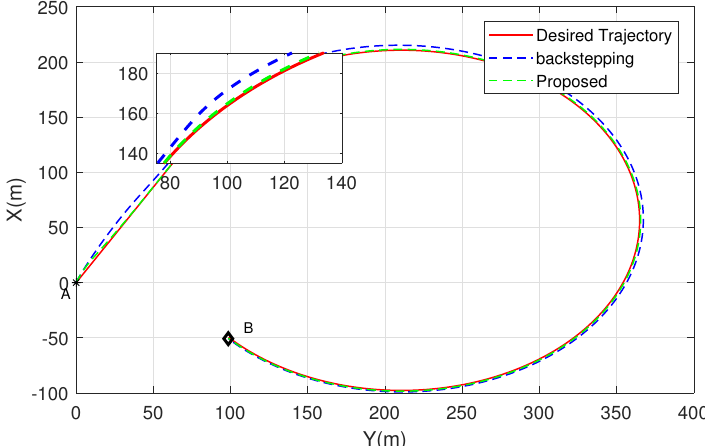
Figure 5. The trajectory of ACV in earth coordinate.